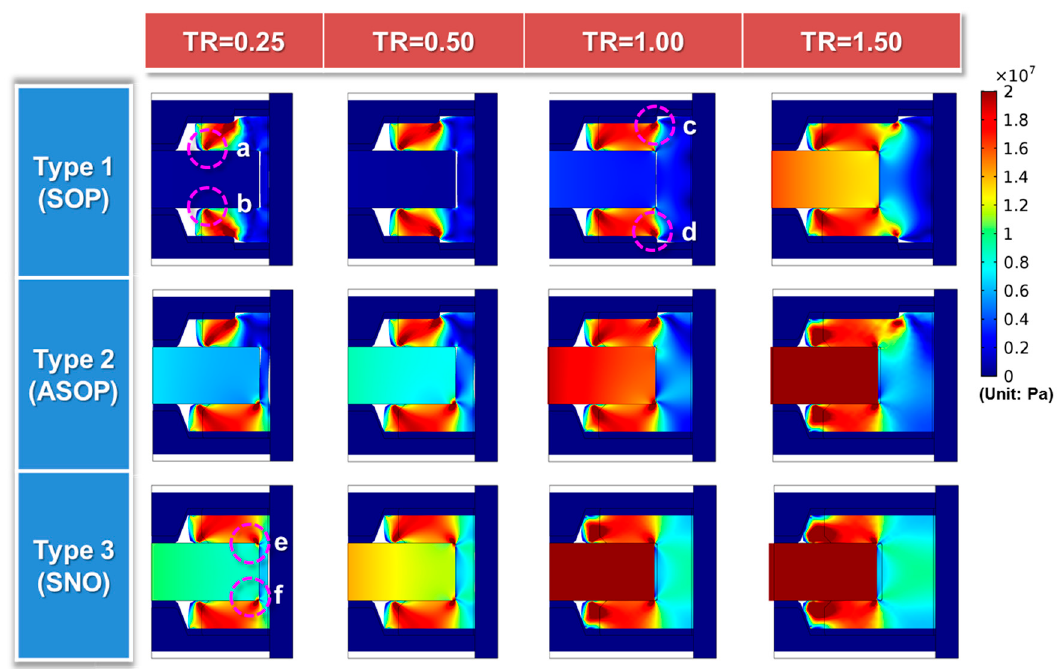
Figure 4. UMS deformation and equivalent stress distribution at 40% of axial compression during assembly. SOP: symmetric open groove; ASOP: asymmetric open groove; SNO: symmetric no groove.